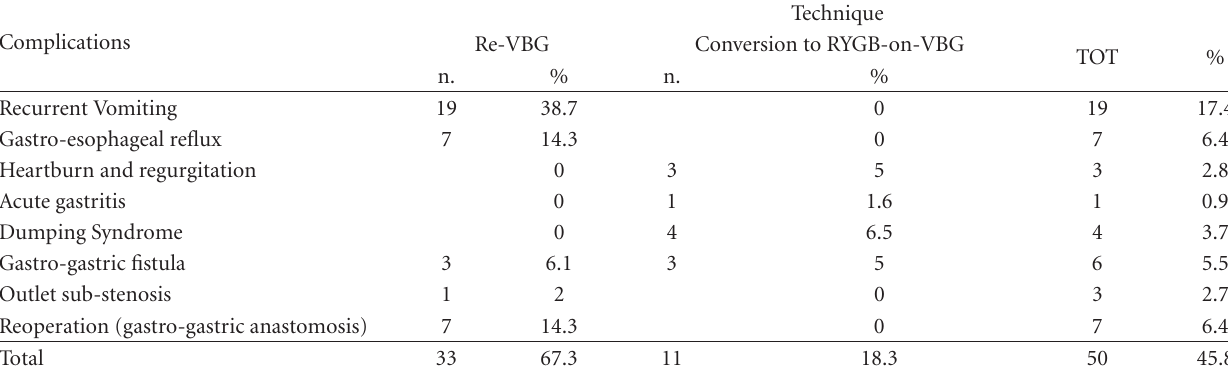
Table 4: Outcomes of revisionary surgery for failed or complicated VBGs: long-term complications.